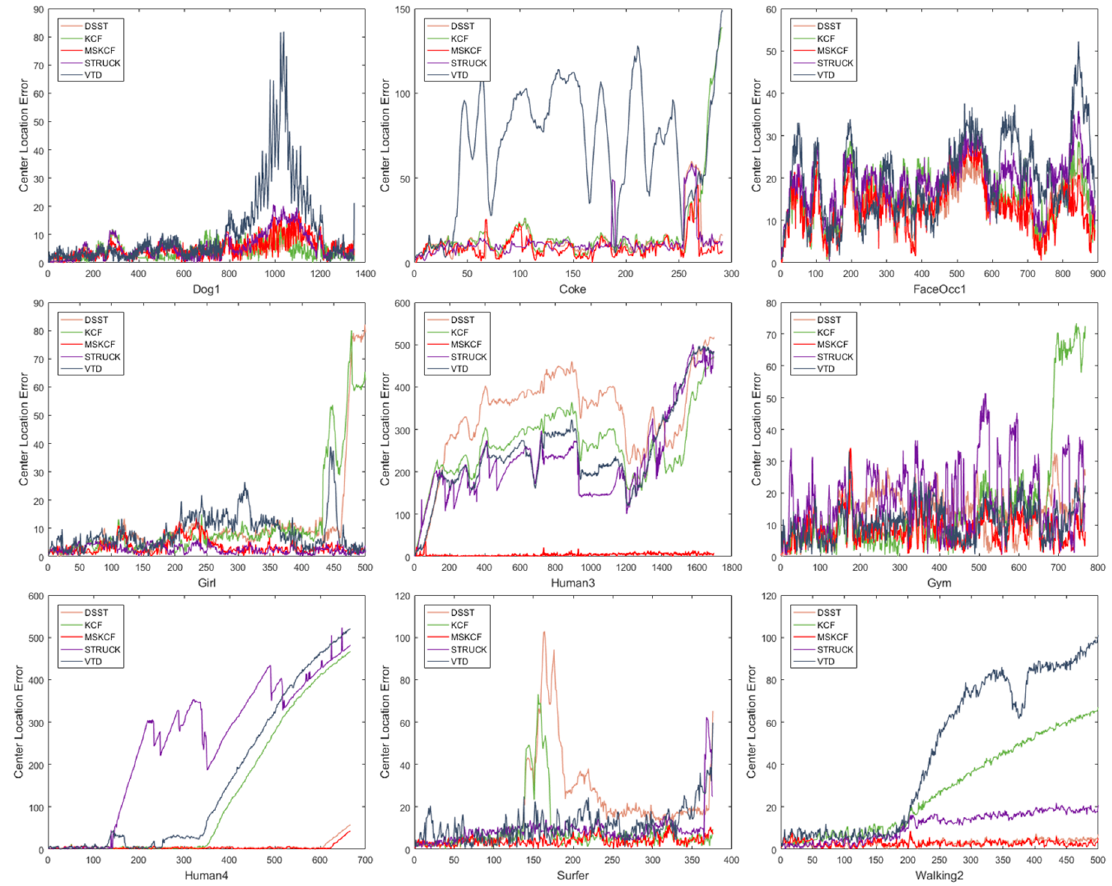
Figure 11. Center location error of each frame. The sequences contain challenging attributes such as scale variation, occlusion, and deformation.